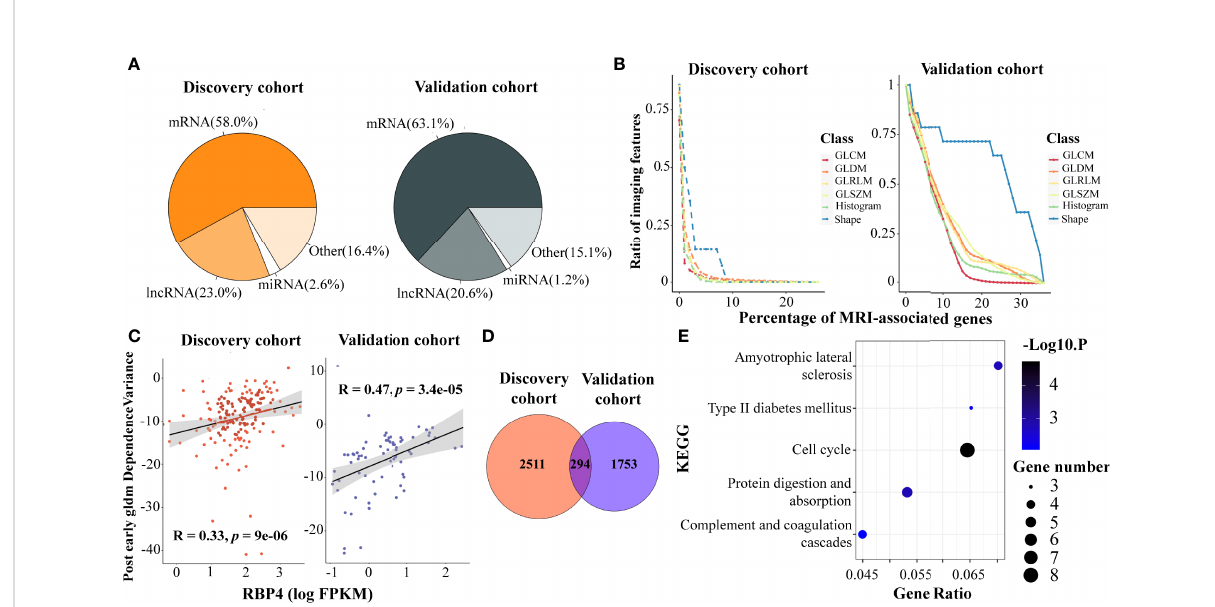
FIGURE 1 Association analysis of DCE-MRI features and BC transcriptomic characteristics. DCE-MRI features associated with molecules including mRNAs and non-coding RNAs in both cohorts (A) . Tumor shape features showed broader association with gene expression than other features. x-Axis represents the percentage of the number of genes, and y-axis denotes the percentage of the number of imaging features related to genes to the total number of features in this feature class. The point on the lower right corner of the curve means that there are fewer proportions of imaging features associated with more genes (B) . The expression of RAP4 was associated with the same imaging feature. x-Axis represents the log2-transformed value of FPKM gene expression, and y-axis denotes the imaging feature value (C) . A total of 294 MRI-associated genes overlapped in the two cohorts (D) , and fi ve KEGG pathways including cell cycle were enriched in these overlapped genes (E) . DCE, dynamic contrast enhanced; BC, breast cancer; FPKM, fragments per kilobase of exon per million reads mapped; KEGG, Kyoto Encyclopedia of Genes and